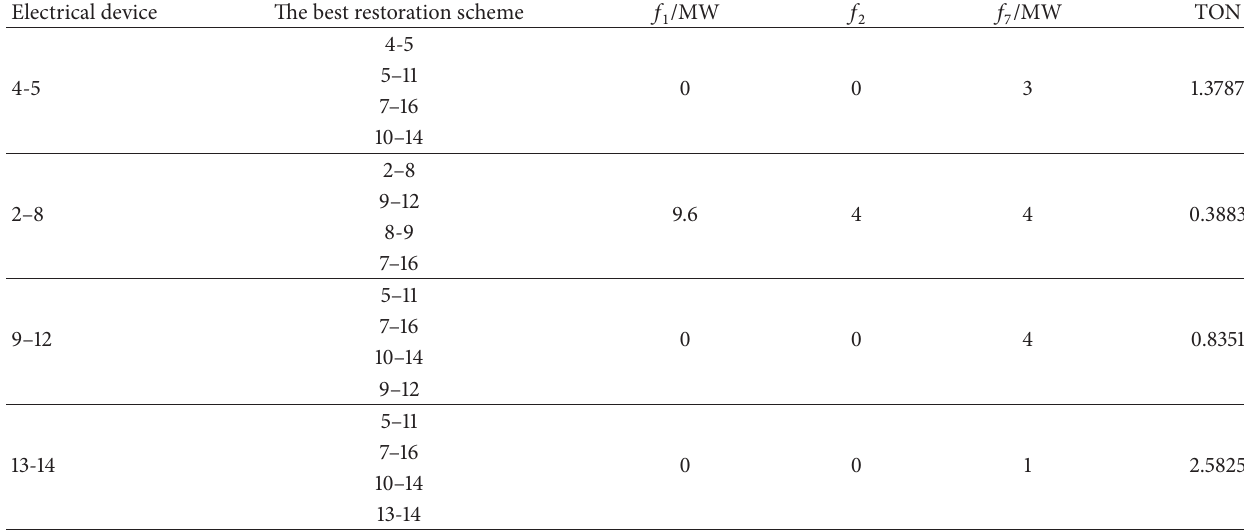
Table 7: The electrical devices of the second kind.